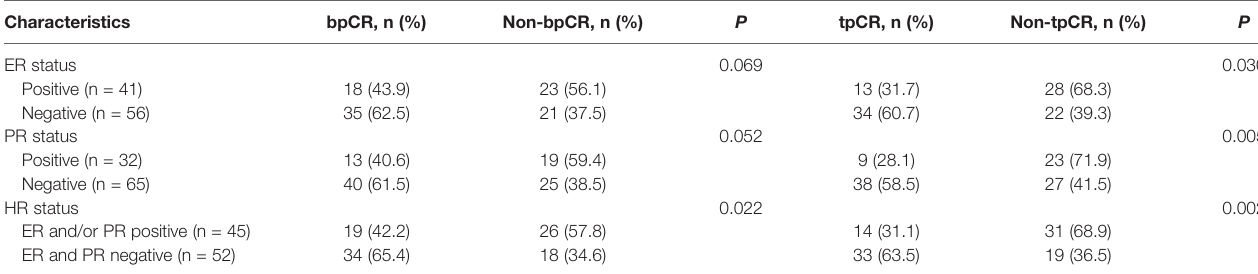
TABLE 3 | Comparisons of bpCR and tpCR rates between subgroups by ER, PR, or HR status. Characteristics